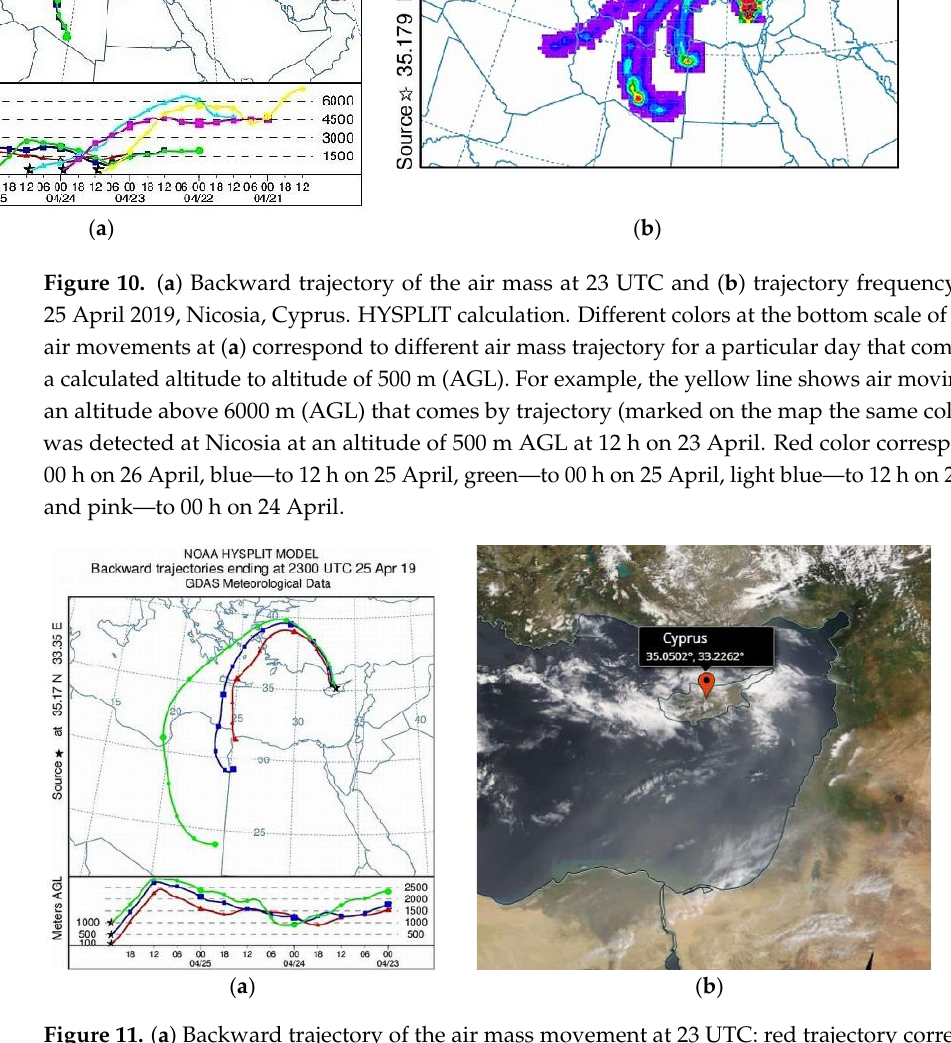
Figure 11. ( a ) Backward trajectory of the air mass movement at 23 UTC: red trajectory corresponds to air mass transport that started at an altitude of 1500 m AGL at 00 h on 23 April and finished at 100 m (AGL) at Nicosia, blue — came from around 2000 m AGL to 500 m AGL and green — from 2500 to 1000 m AGL (map shows the horizontal movement and scale at the bottom the vertical movements of air mass), and ( b ) Aqua/MODIS image on 25 April 2019 [53], Cyprus, Eastern Mediterranean.